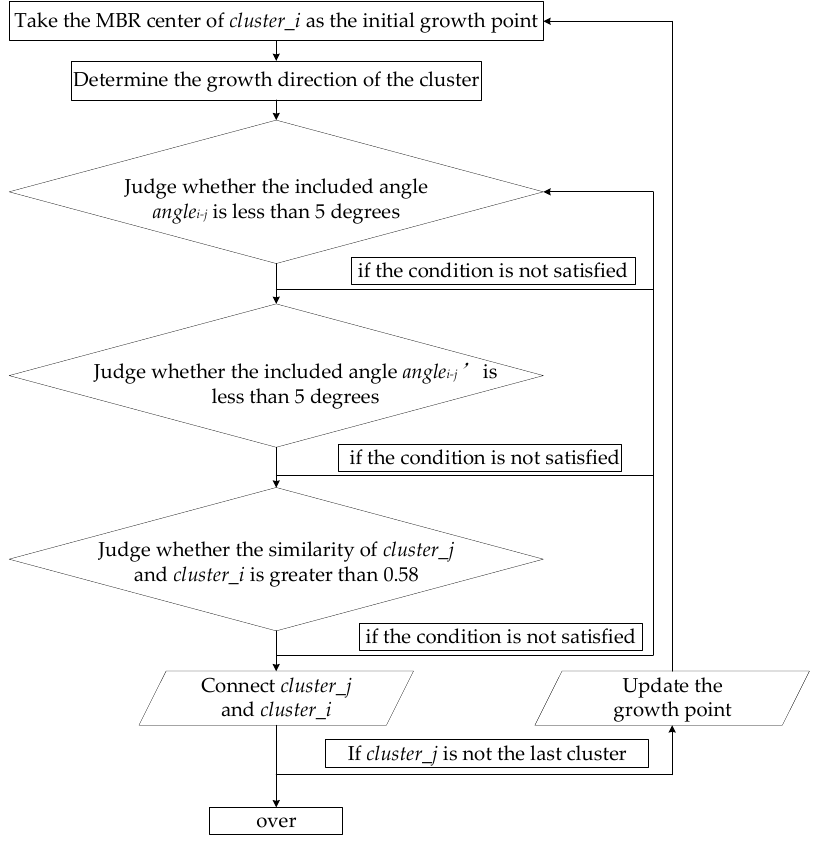
Figure 10. Line self-growth algorithm flow chart.